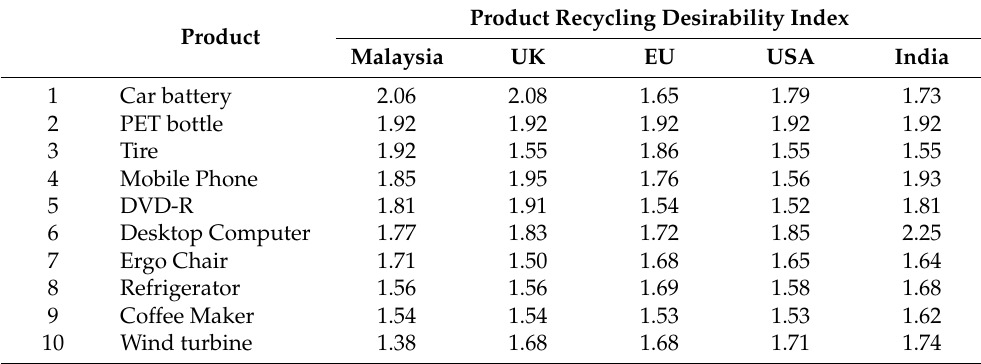
Table 10. Comparison of Malaysian products recycling desirability index with other